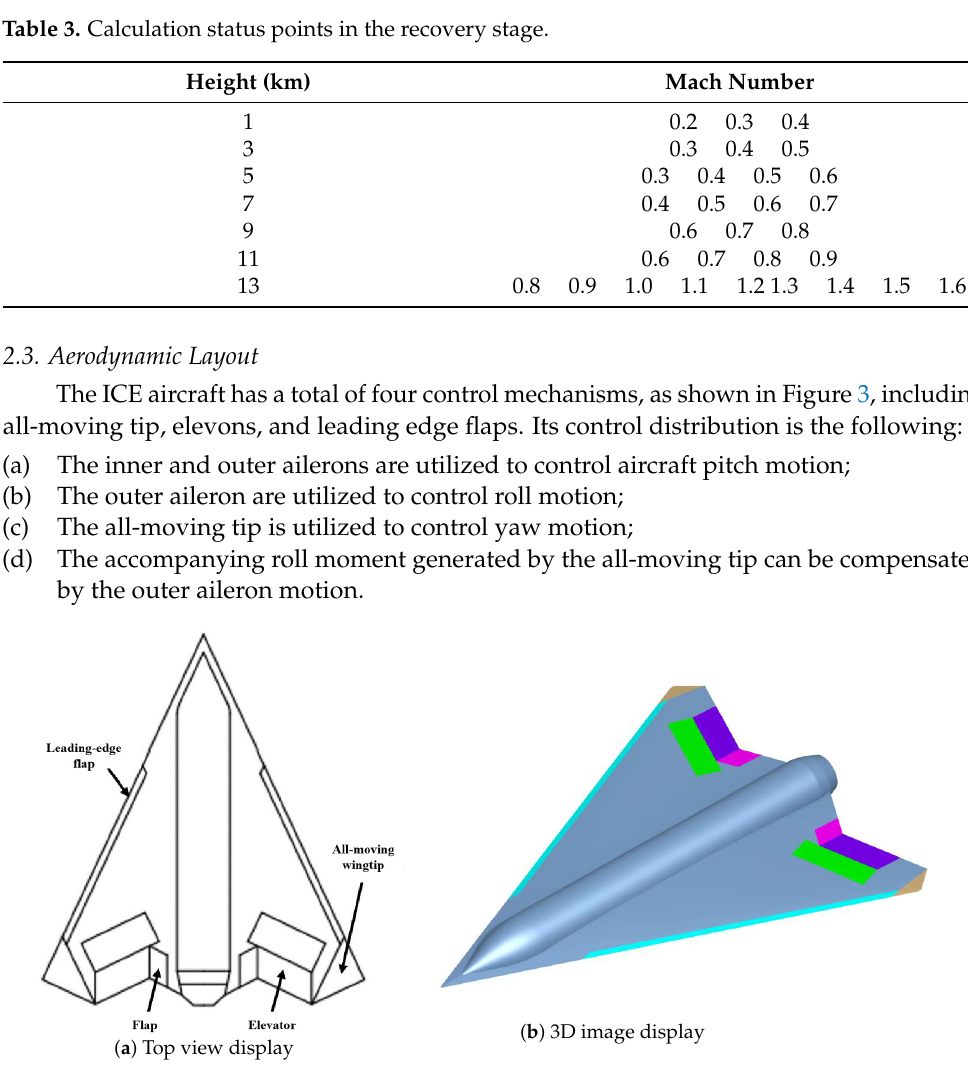
Figure 3. The configuration of ICE aircraft control